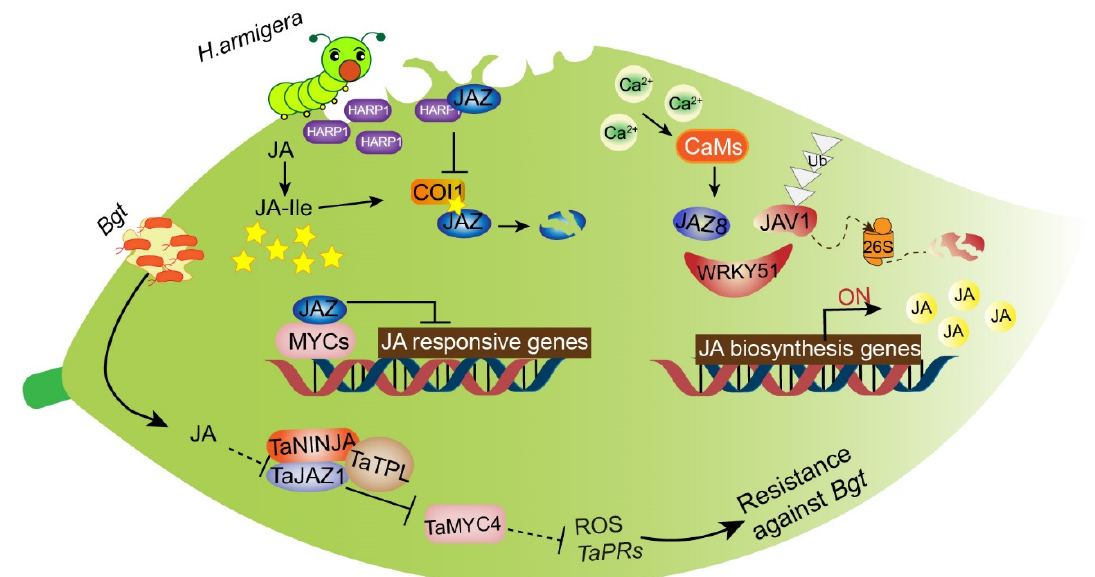
Figure 7. The JA signaling pathway in response to biotic stresses in plants. In wheat, pathogen and insect damage activate the JA signaling pathway. When bread wheat is inoculated with Bgt , JA accumulation results in TaJAZ1 degradation to release TaMYC4, inhibiting reactive oxygen species accumulation and TaPRs expression and thereby showing resistance to Bgt . On the other hand, the chewing insect-derived effector HARP1, secreted from Helicoverpa armigera, accumulates in leaves and then interacts with JAZ to repress the interaction of COI1 and JAZ, thus preventing JAZ degradation and inactivating the expression of JA-responsive genes to decrease the plant’s resistance to insect damage. In addition, during insect herbivory, the JJW complex is disintegrated due to the rapid induction of Ca 2+ /calmodulin-dependent phosphorylation of JAV1, thereby de-repressing JA biosynthesis genes and causing a rapid burst of JA for plant defense. Abbreviations: HARP1, caterpillar-derived effector; ROS, reactive oxygen species; PR1/2, pathogenesis-related gene1/2; JAV1, Jasmonate-associated VQ domain protein 1; JA, jasmonic acid; JAZ, jasmonate zim domain protein; JA-Ile, jasmonic acid isoleucine; NINJA, novel interactor of JAZ; TPL, topless.